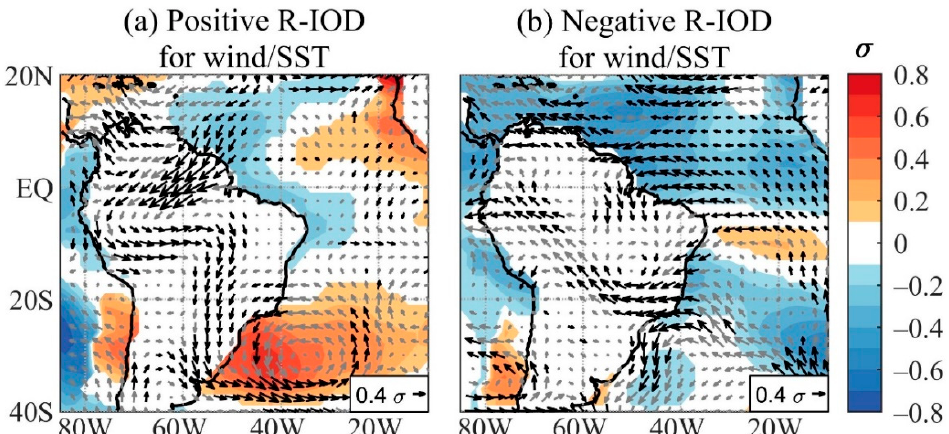
Figure 13. Composites of the anomalies of the residual 850hPa winds and SST (shades) during austral spring for the: ( a ) positive R-IOD; and ( b ) negative R-IOD. Shades encompass significant values at a 95% confidence level using the Student’s t -test. In this Figure, residual means without the TPO effects. The arrow in the right-lower corner gives the vector base magnitude in S.D. units. Bold arrows indicate vectors when at least one component has a significant 95% confidence level value.